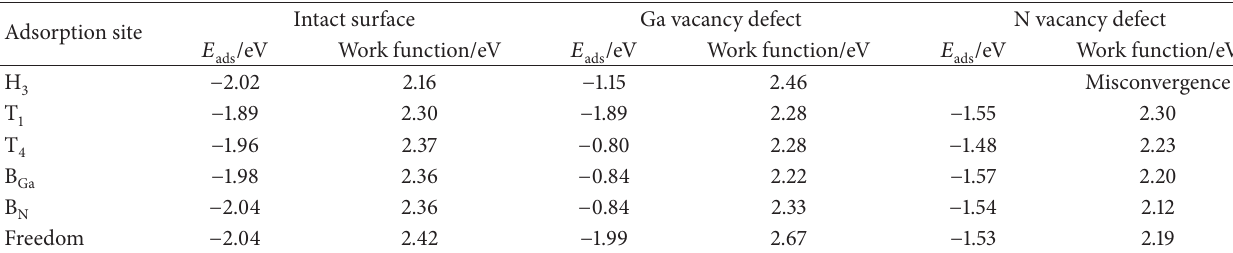
Table 3: 𝐸 and work functions of Cs on GaN(0001) intact, Ga vacancy defect, and N vacancy defect surfaces. ads Adsorption